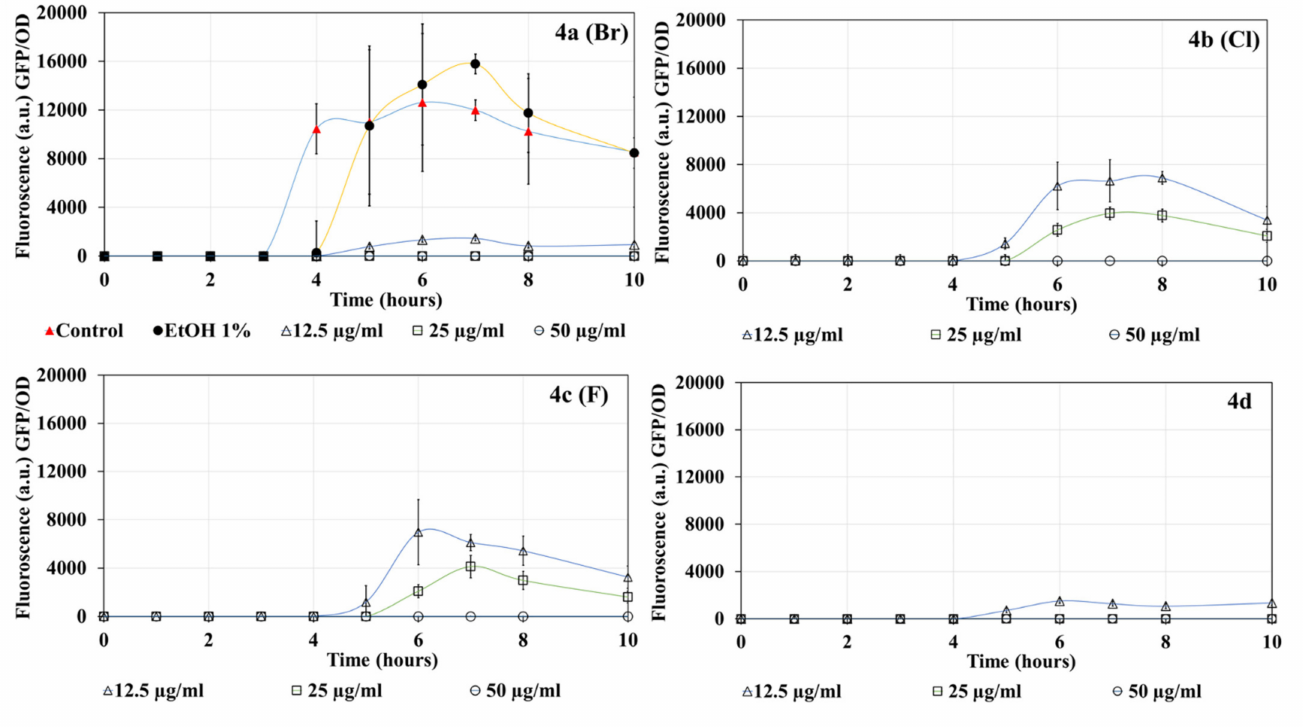
Figure 2. Effects of DHP compounds (12.5–50 µ g/mL) on the production of GFP mediated through LasR in P. aeruginosa